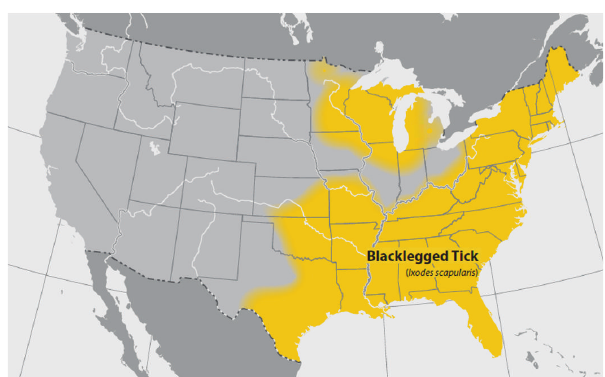
Figure 1: Geographic distribution of I. scapularis within the conti- nental United States. Yellow shaded areas represent the distribution of I. scapularis in the northeastern and upper midwestern United States